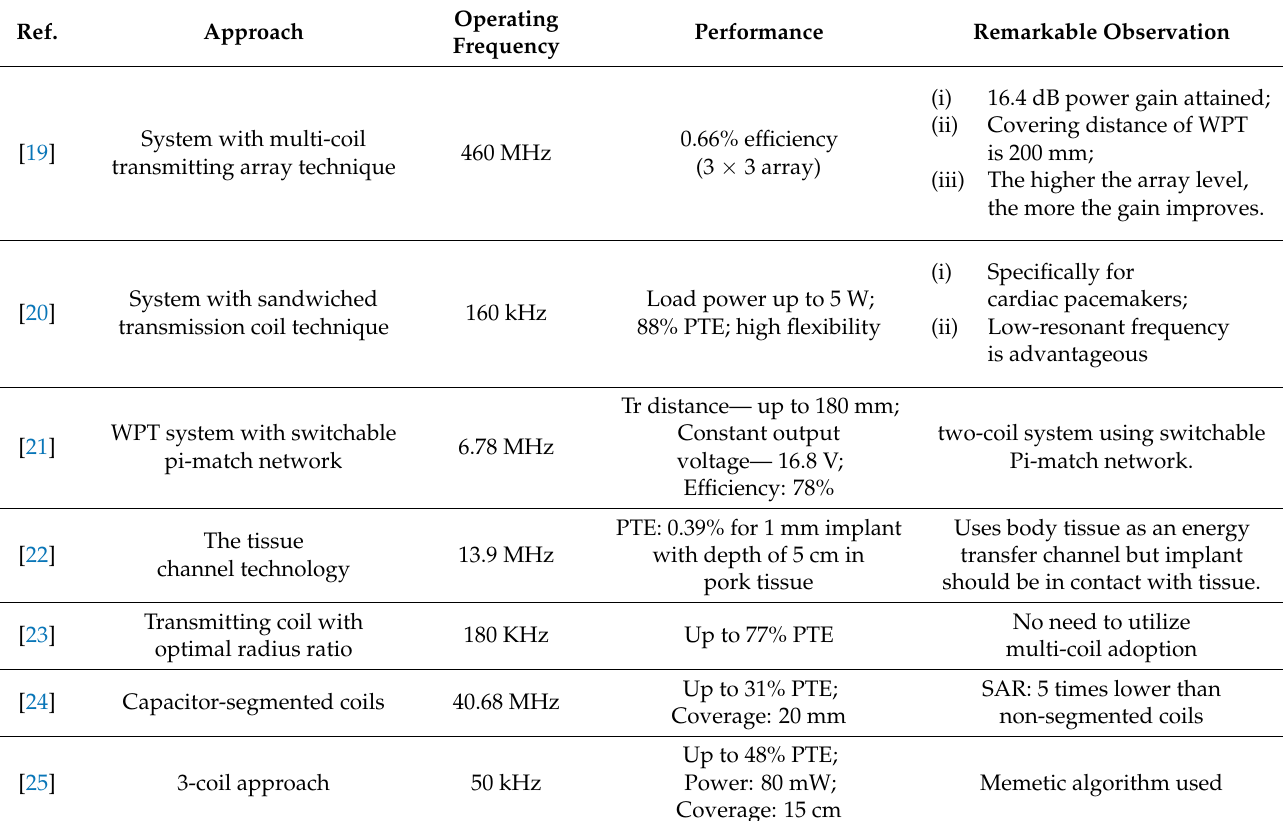
Table 1. WPT systems based on different transmitting and receiving coil technique.